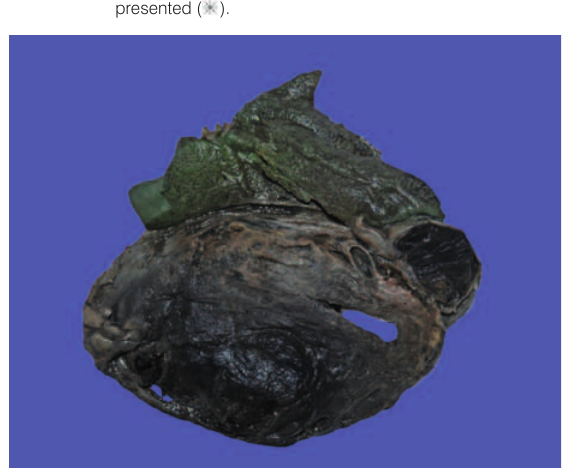
Figure 3. Gross apearrance of the tumor on autopsy (total size 17 x 5 cm).